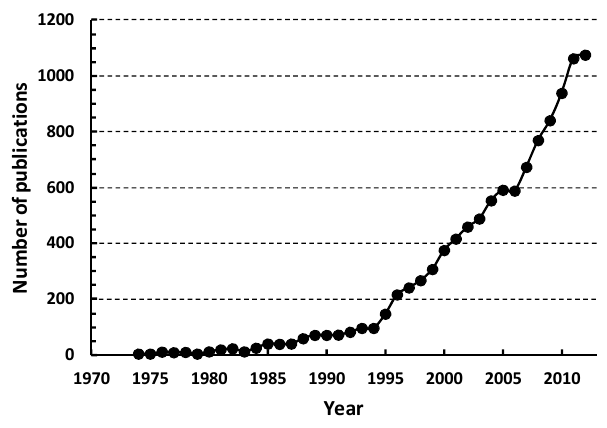
Fig. 1. Number of manuscripts published on “haz- Figure 1. Number of manuscripts published on “hazards”+”risk”+”agriculture” terms 3 ards” + “risk” + “agriculture” terms from 1970 to 2012 recognised in SCOPUS from 1970 to 2012 recognized in SCOPUS database. 4